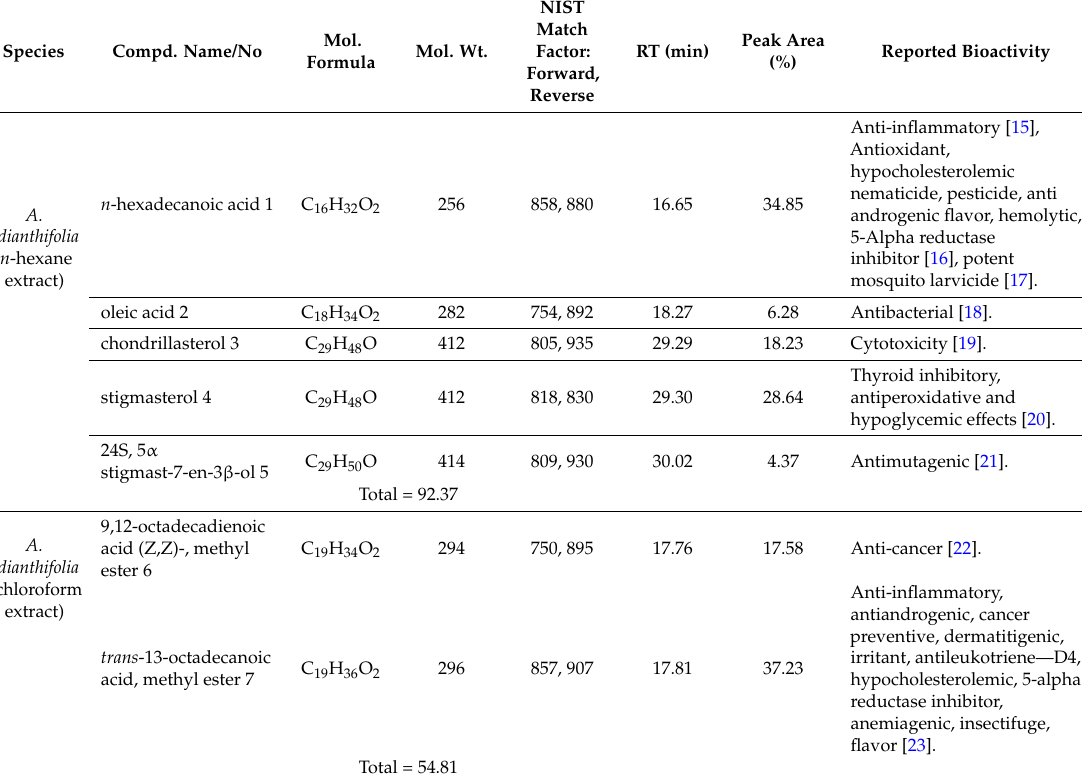
Table 1. Phyto-constituents identified from heartwood of A. adianthifolia by GC-MS analysis.